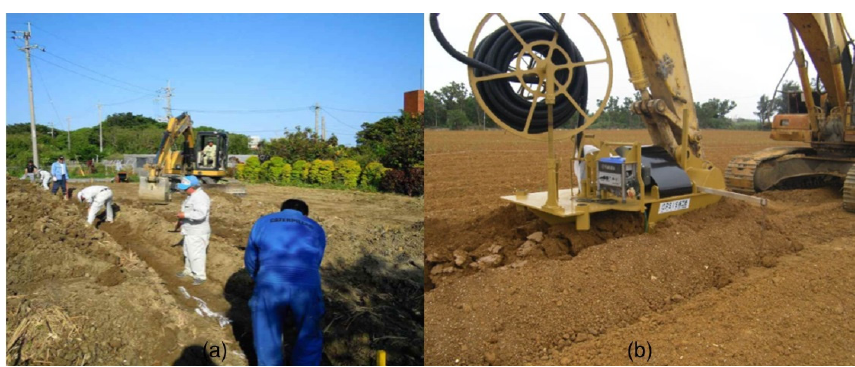
Figure 9. Installation of OPSIS lines ( a ) Manually laying out lines, ( b ) Use of machine to lay out lines.